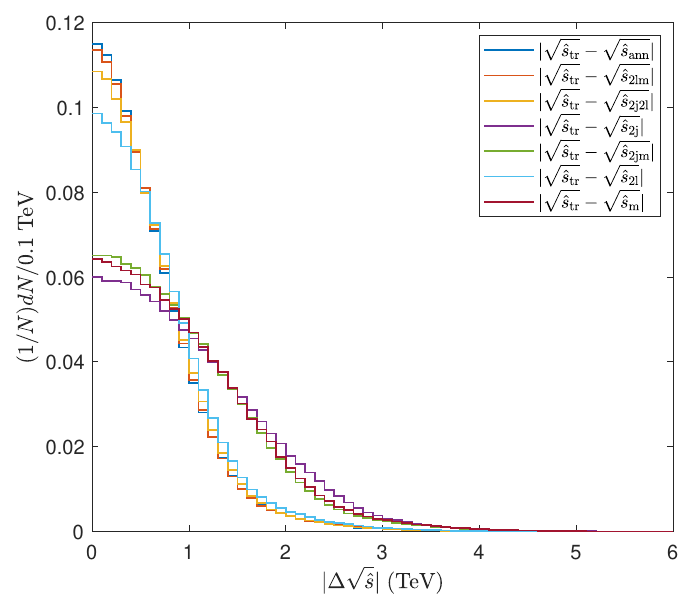
√ ˆ s | for ˆ s ann , ˆ s 2lm , ˆ s 2jm , ˆ s 2j2l , ˆ s 2l , ˆ s 2j and ˆ s m